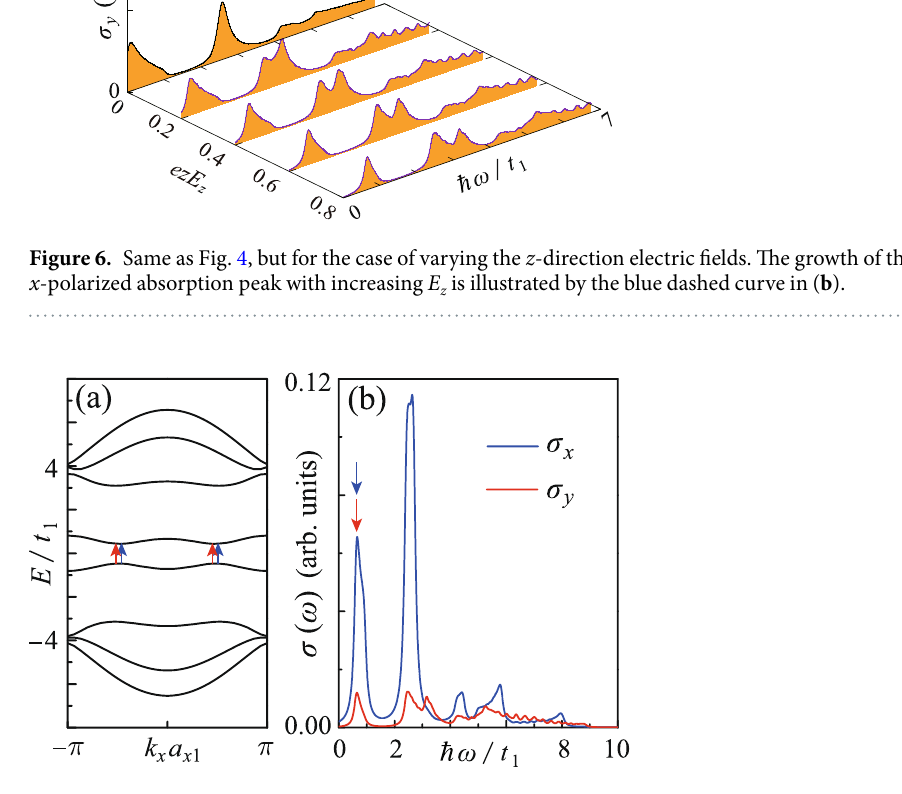
Figure 7. ( a ) When t 3 / t 1 = 0 and eE z z = 0.6 t 1 , the electronic band structure shows the e-h symmetry and thus the electric-field-induced band gap is direct. ( b ) The electric-field induced absorptions of the x - and y -polarized photons with energy resonating to the